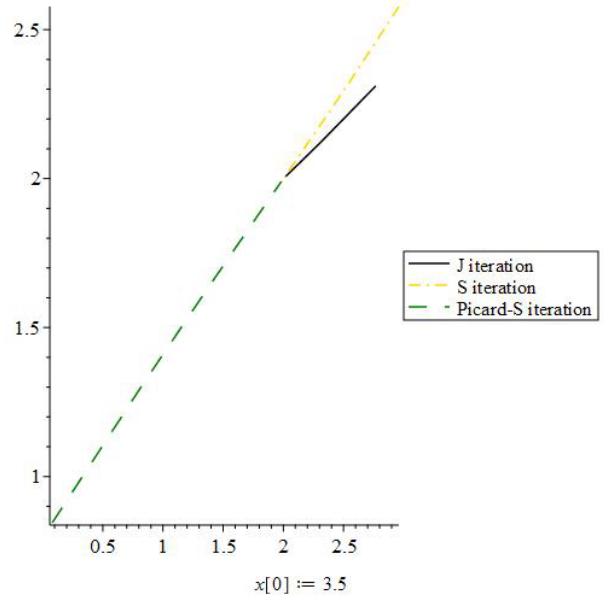
Figure 1. J iteration process convergence when the initial value is 3.5.